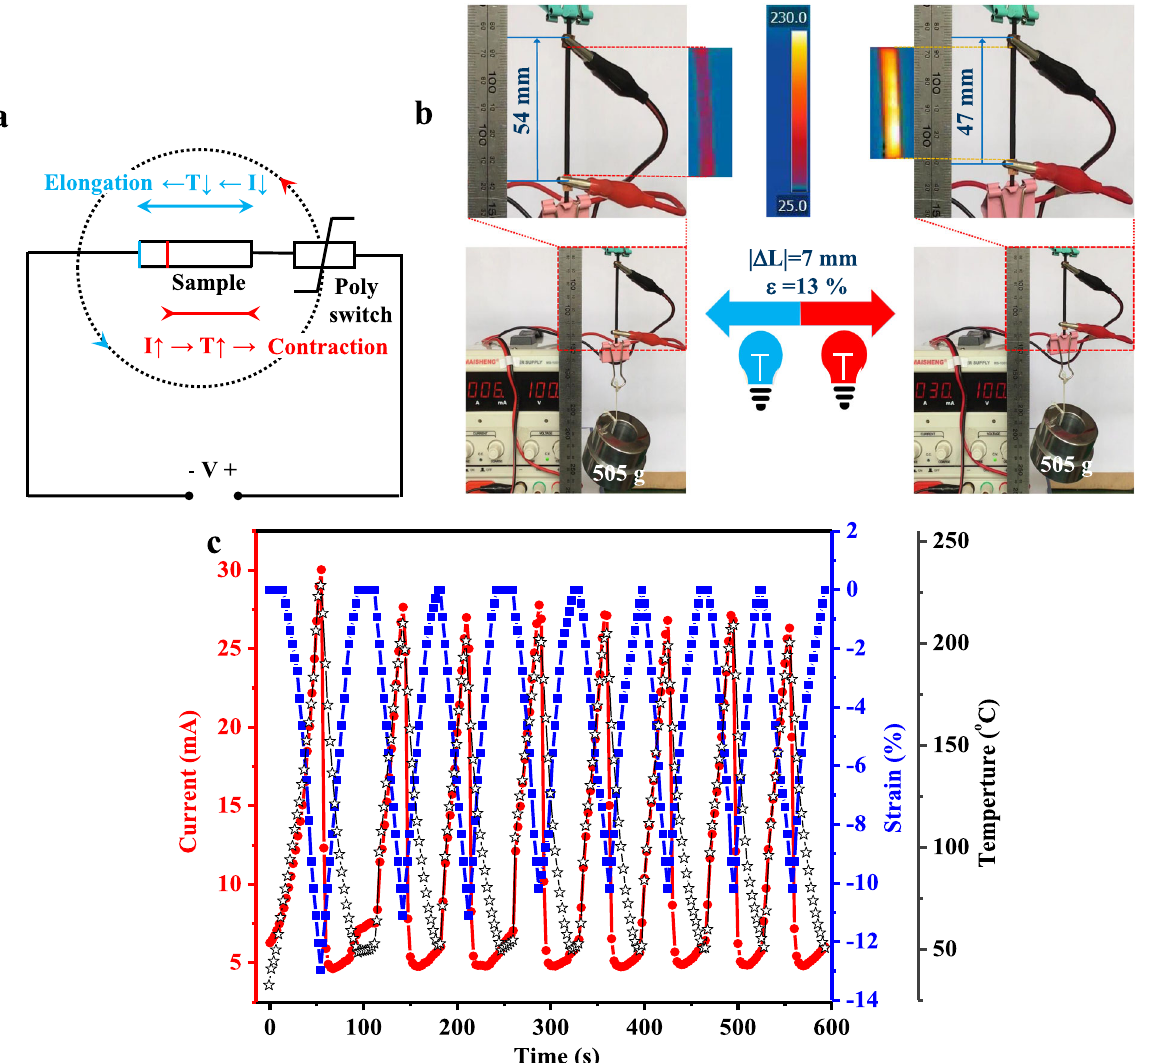
Fig. 7 Electric-programmable actuation performance. a Schematic diagram of the circuit for the electric-programmable actuation tests. b Photographs of the length change of L20C20Z12@300% under varied current signals (the color change of bulbs represent the variation of the current). c Quantitative evaluation of the variation of actuation strain in response to the current signal in the electric-triggered actuation tests. Source Data for Fig. 7c is available as an associated article fi